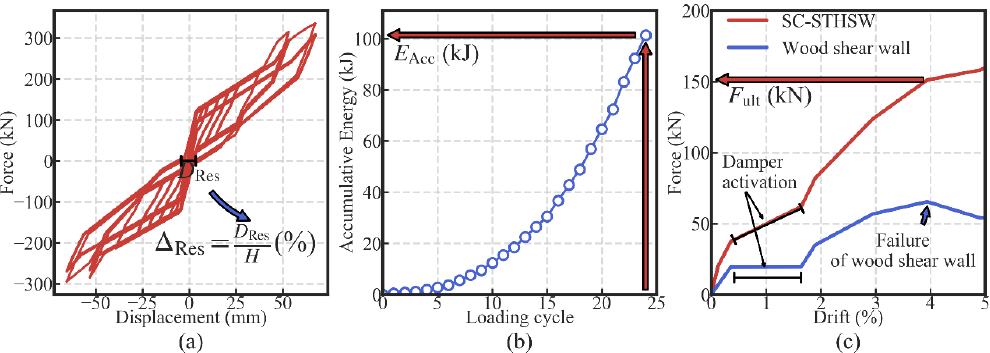
Figure 13. The definition of the performance targets: ( a ) the residual drift; ( b ) the accumulative energy dissipation; and ( c ) the ultimate strength.